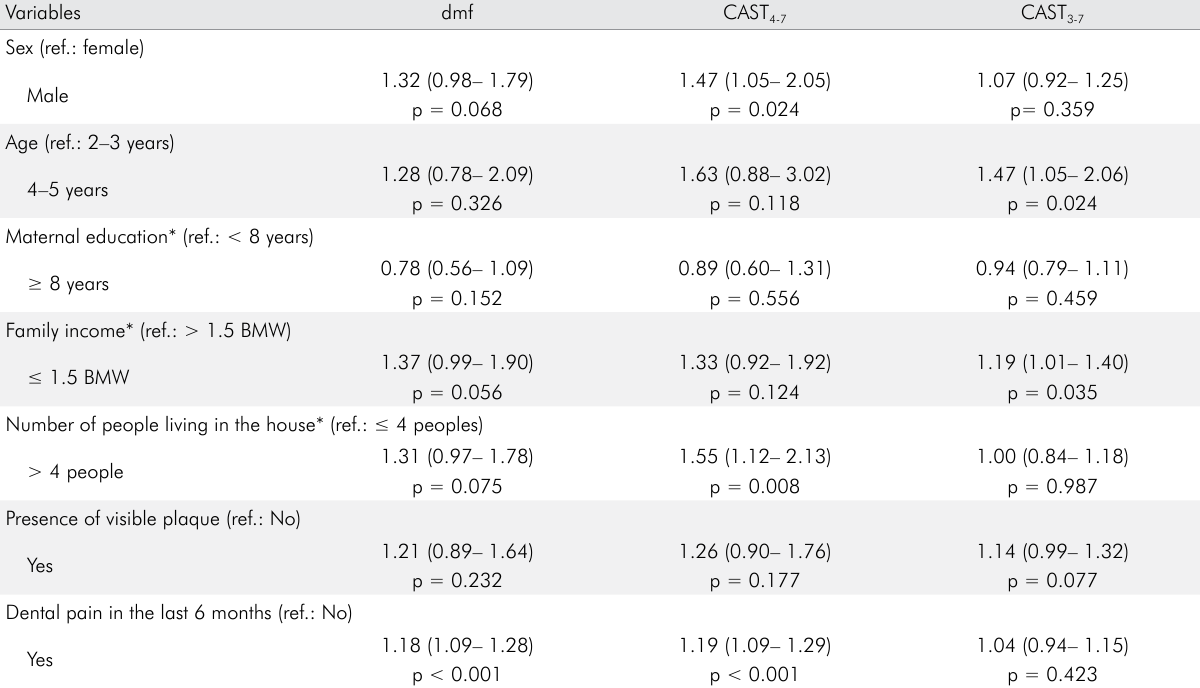
Table 3. Prevalence ratio values (95%CI) calculated by Poisson regression, using children with caries as the outcome according to CAST at thresholds CAST and CAST and to the dmf index and independent variables (n = 200). 4-7 3-7